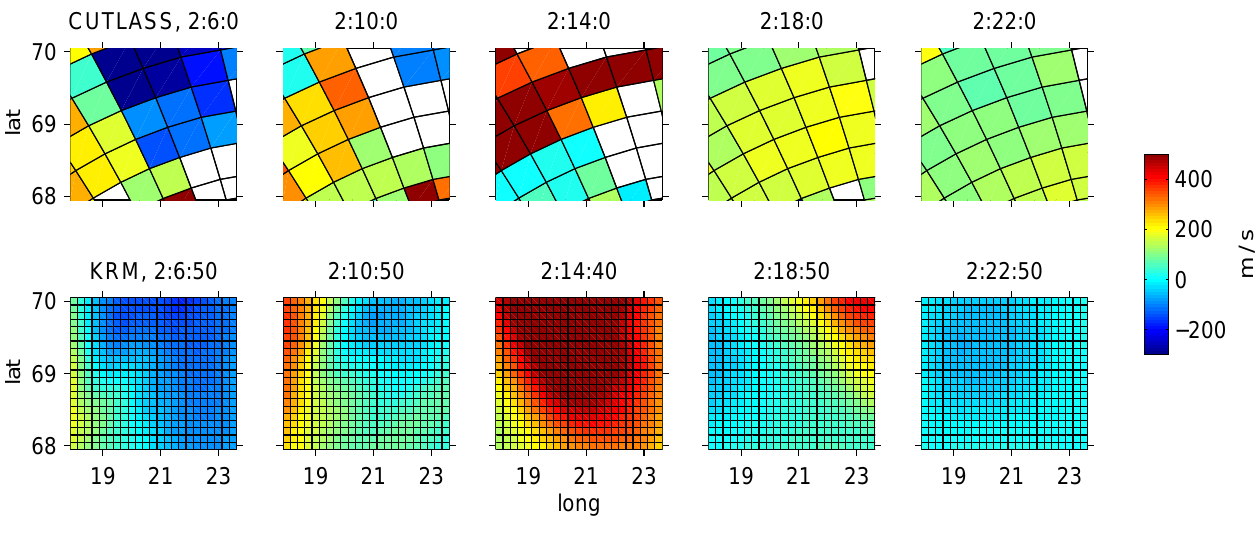
Fig. 15. The line-of-sight plasma velocity measured by the Finnish CUTLASS radar and the same component of the E × B drift velocity calculated from the local KRM results. Comparison is shown for 5 time steps, so that the CUTLASS results are in the top row and cor- responding local KRM results in the bottom row. Positive velocity is towards the radar, indicating that the ionospheric electric field has a westward